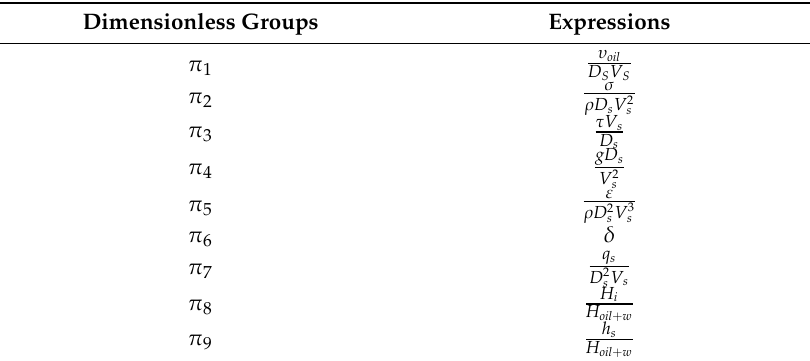
Table 3. Expression of dimensionless groups based on Equations (8) and (9). Dimensionless